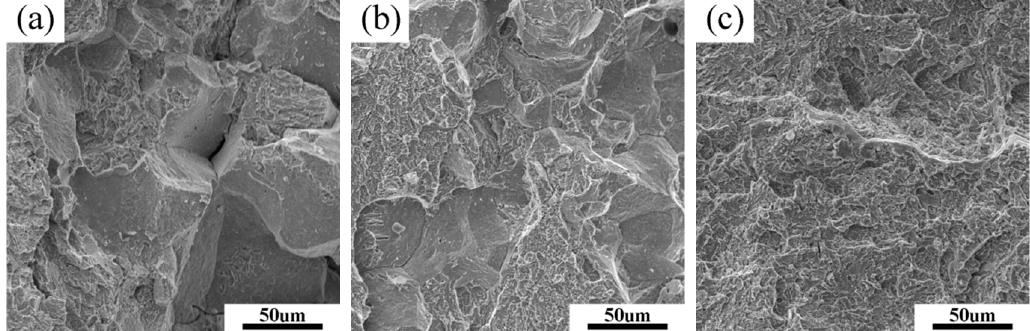
Figure 7. Fractograph of the tensile sample with the heat input of 4.2 kJ/cm. ( a , b ) Fusion zone fracture; and ( c ) tempering zone fracture. Metals 2018 , 8 , x FOR PEER REVIEW